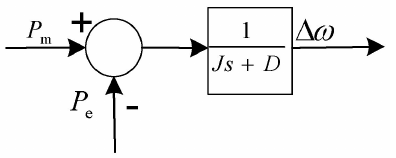
Figure 4. Transfer function of angular velocity and power.